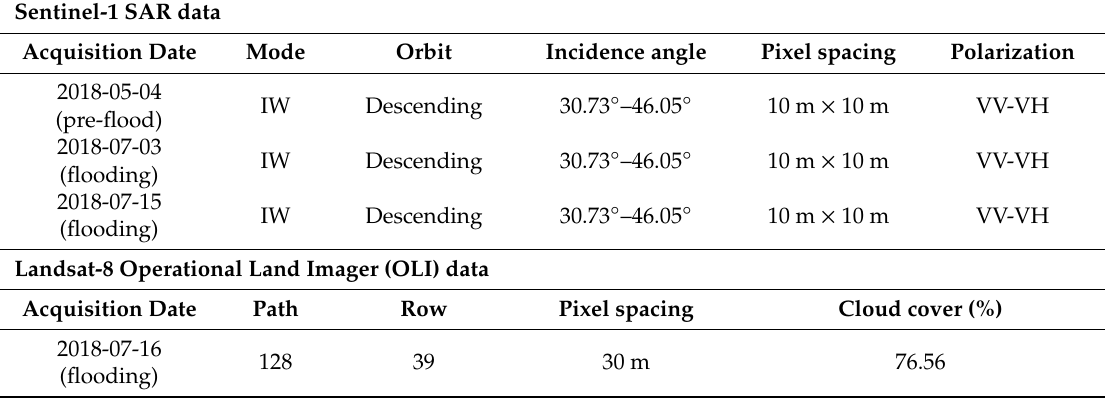
Table 1. Available Synthetic Aperture Radar (SAR) and Landsat-8 data for the flooding event in the study area.